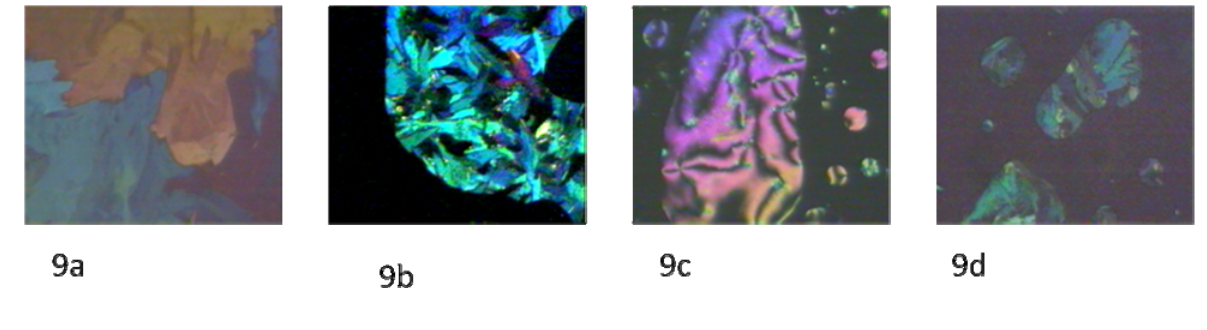
Figure 9. (9a) Crystalline-Smectic phase transition state; crossed polarizers, 97 ° C, × 150. (9b) Smectic phase (smectic A) with broken fan-shape texture; crossed polarizers, 97 ° C, × 150. (9c) Nematic schlieren texture with point singularities;crossed polarizers, below 138 ° C, × 150. (9d) Smectic phase upon cooling exhibited broken fans; crossed polarizers, 57 ° C, × 150.